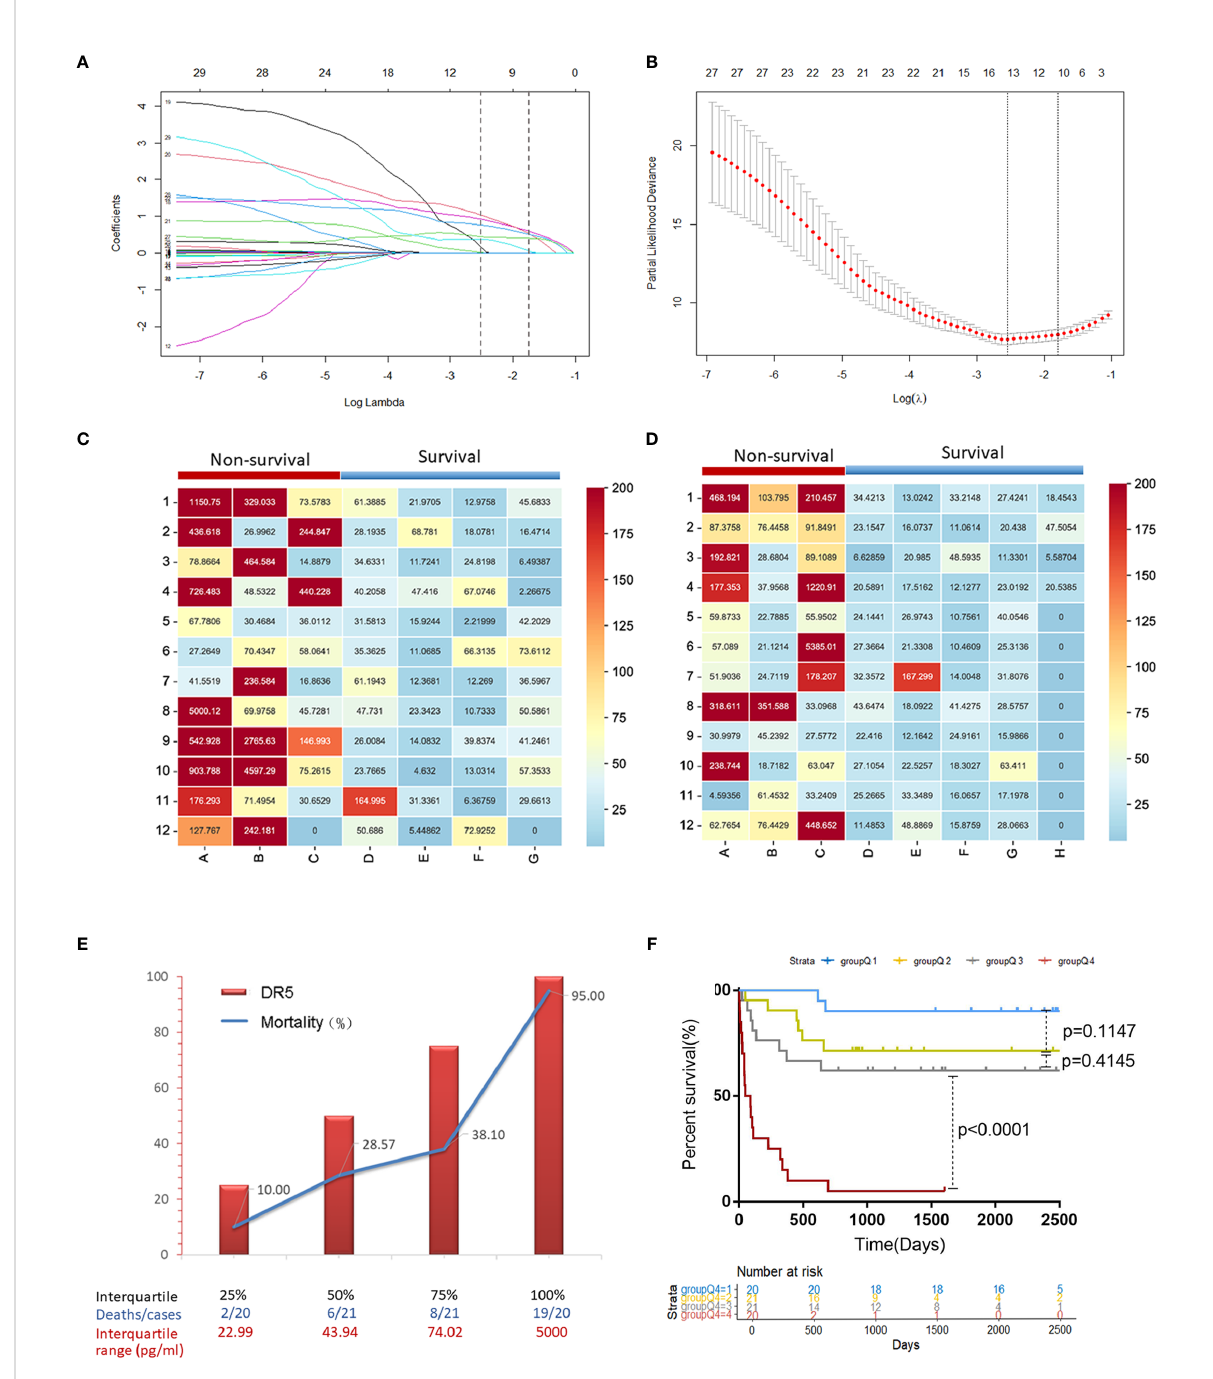
FIGURE 2 The predictive factor sDR5 was selected using LASSO regression analysis, and the correlation between serum sDR5 levels and mortality of patients with HBV-related HCC. (A) The LASSO coef fi cient pro fi les of the clinical features. (B) Optimum parameter (lambda) selection in the LASSO model performed with ten-fold cross-validation. The Matrix heatmap shows expression of sDR5 in patients with different prognosis in derivation cohort (C) and validation cohort (D) . (E) Comparison of mortality in HBV-HCC patients between four different concentration gradients of serum sDR5 based on the interquartile range. (F) Survival curves of the mortality in four groups based on the interquartile range of DR5 values using the Kaplan – Meier